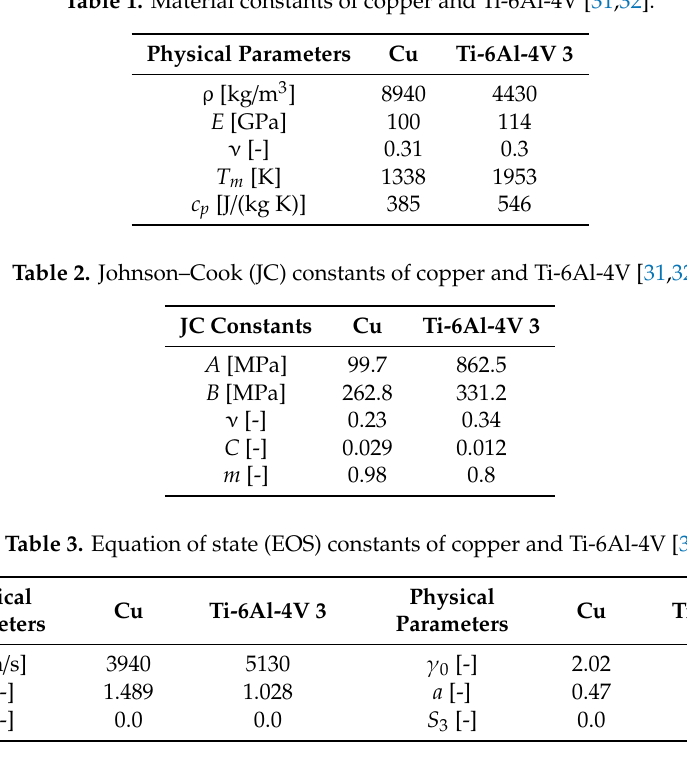
Table 1. Material constants of copper and Ti-6Al-4V [31,32].